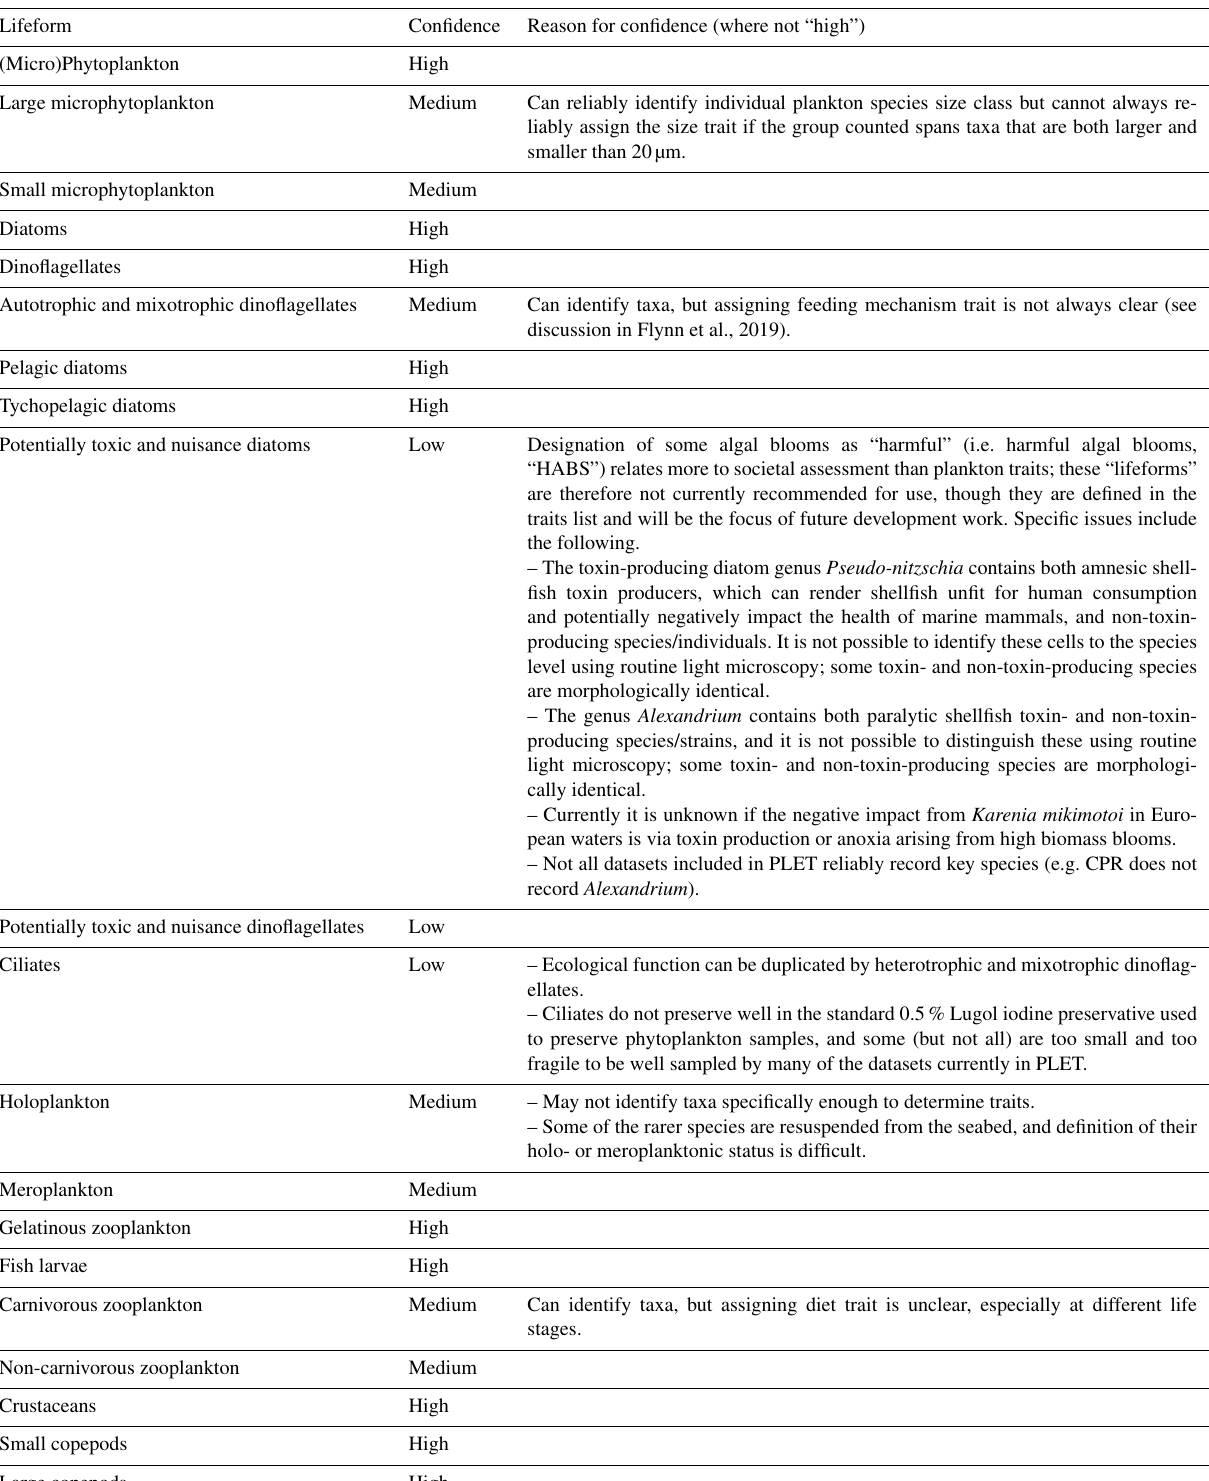
Table 4. Lifeform confidences based on ability to identify and assign traits, applying rationale in Table 3. Only lifeforms with a “high” confidence rating are provided in the PLET